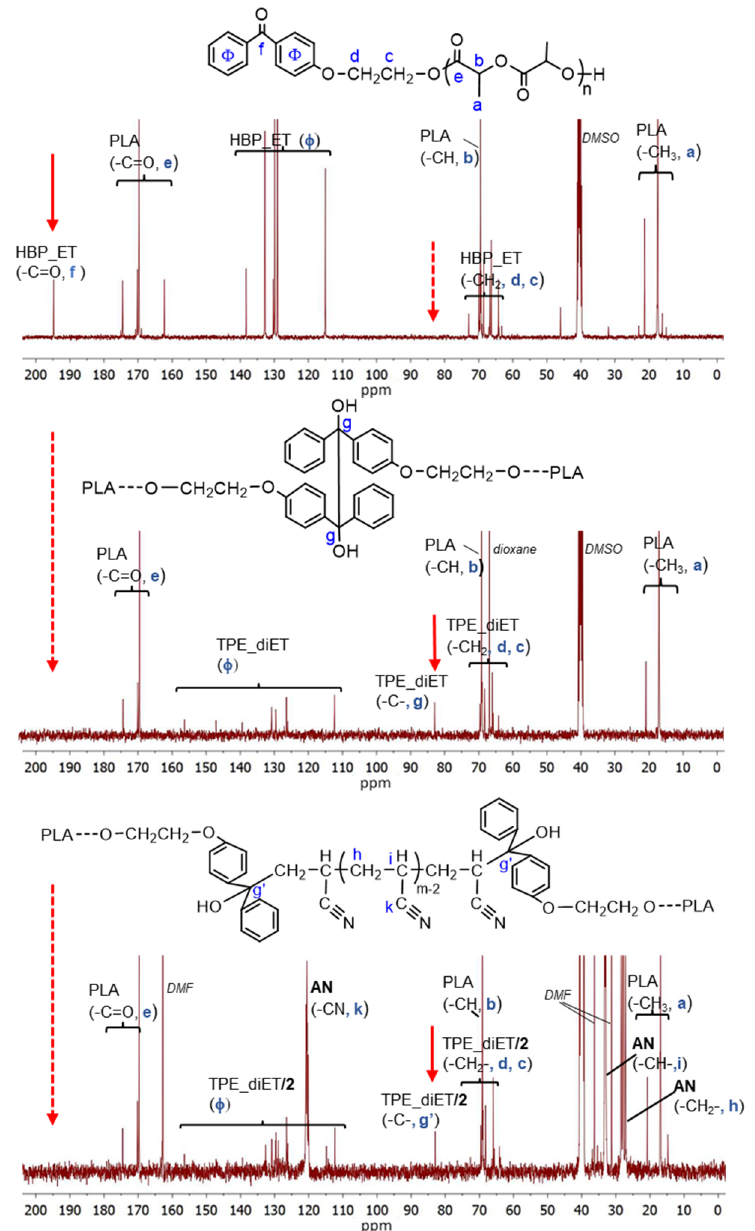
Figure 8. 13 C NMR spectra of HBP-ET_PLA (before coupling), TPE-diET_PLA (after coupling), and